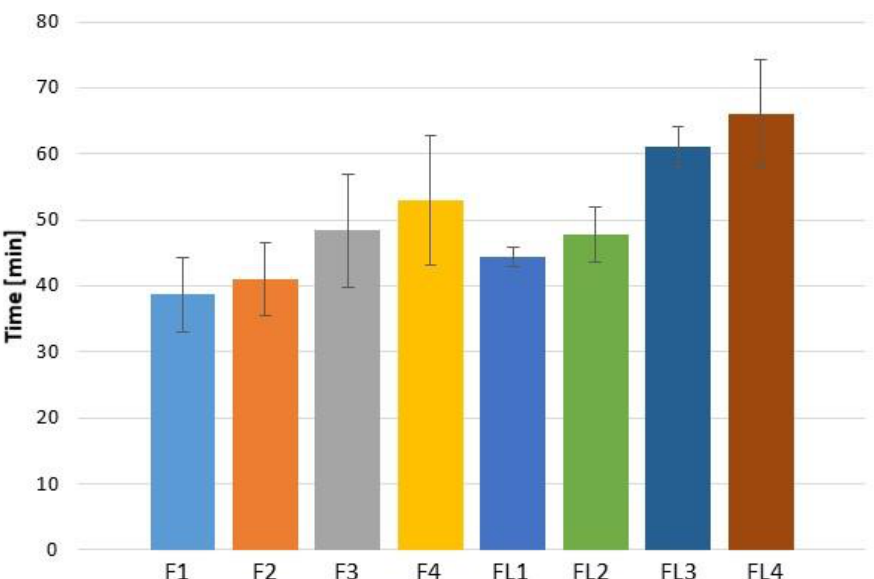
Figure 8. Ex vivo retention time of placebo (F1–F4) and LUL-loaded (FL1–FL4) microparticles (mean ± SD, n = 3).